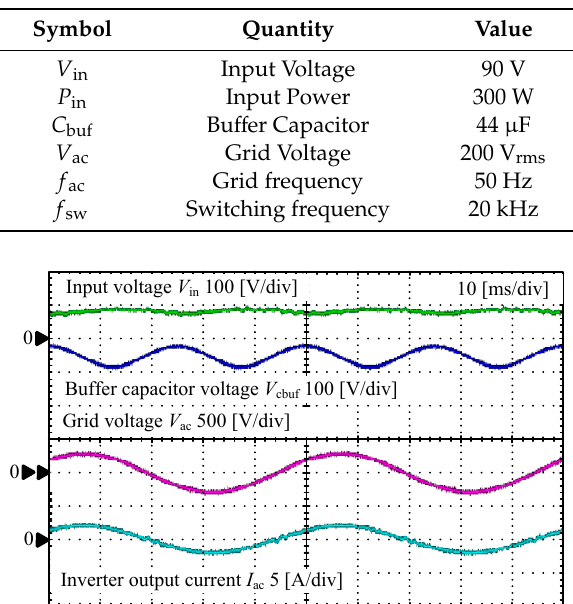
Table 1. Experimental parameters.